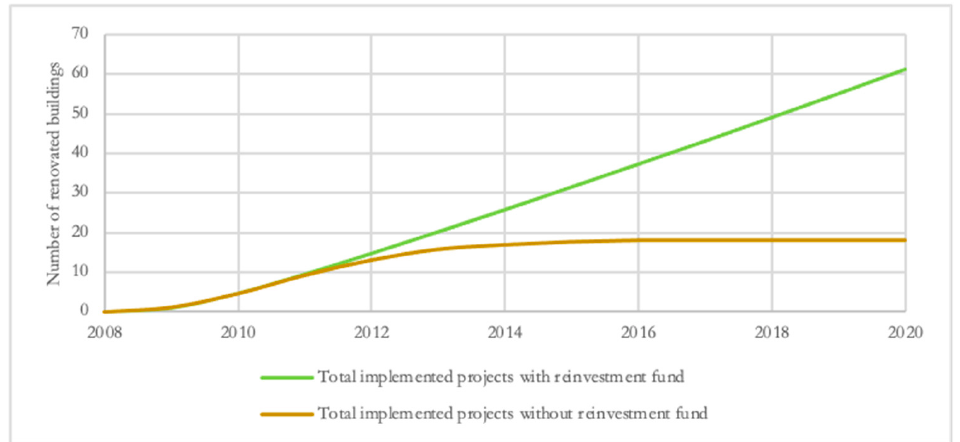
Figure 17. Simulated number of ESCO-renovated buildings with actual policy tools in place and with and without reinvestment fund.